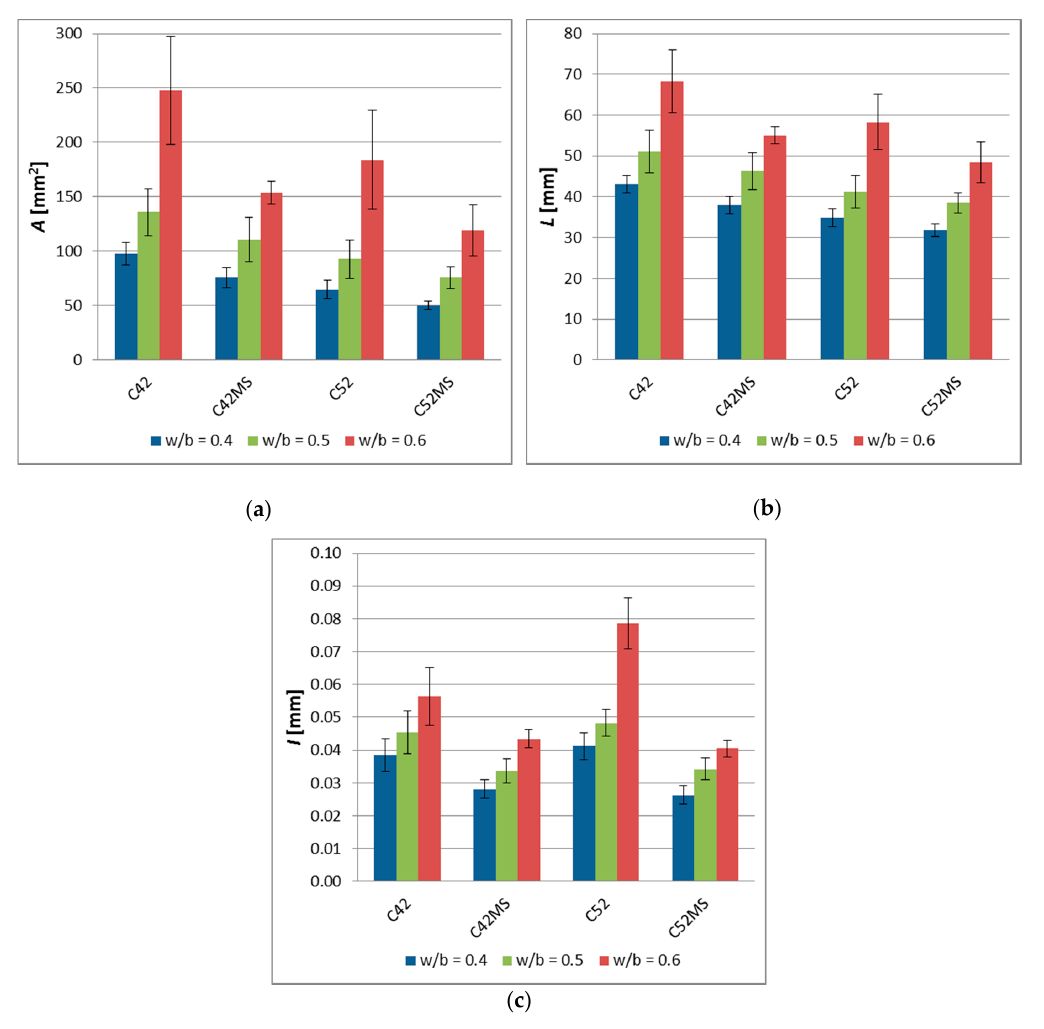
Figure 3. The image analysis results of the cement pastes (error bars mean standard deviations): ( a ) Cluster average area— A ; ( b ) cluster average perimeter— L ; ( c ) crack average width— I .